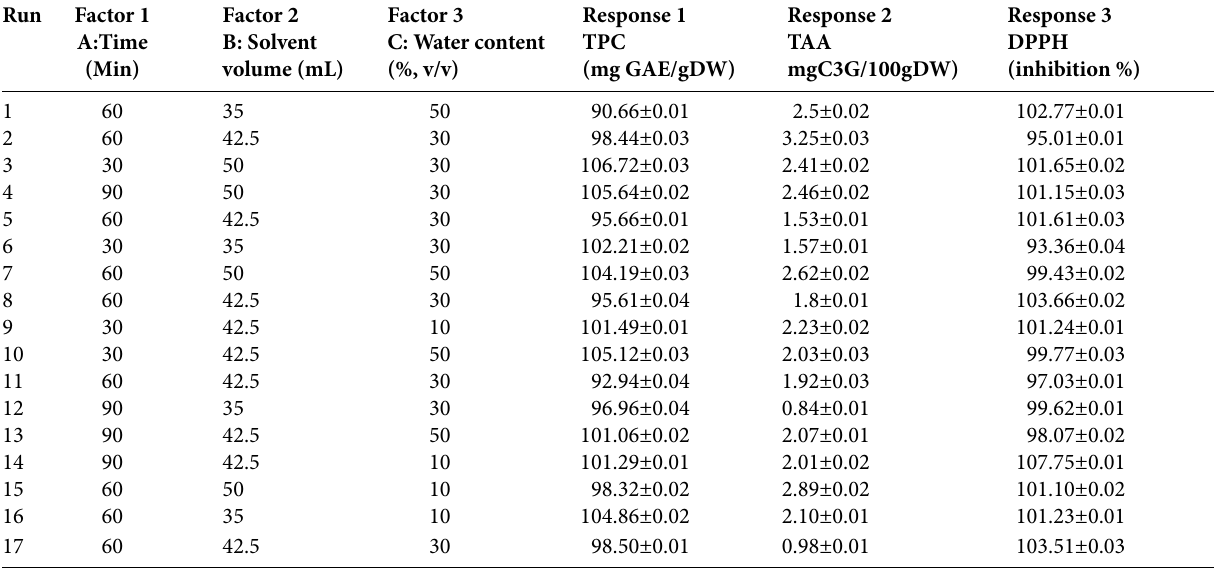
Table 4. Effects of operation factors on the responses of Rosa canina L. fruits extract obtained by UAE Run Factor 1 Factor 2 Factor 3